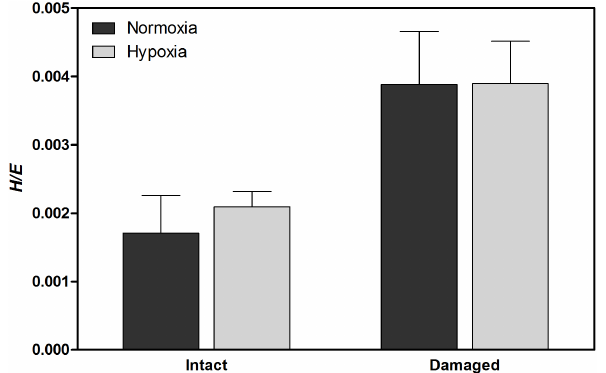
Figure 3. Vickers hardness to elastic modulus ratio ( H/E) , indicat- ing mechanical strength, of H. diramphus shells produced in differ- ent treatments (mean + S.E.; n =